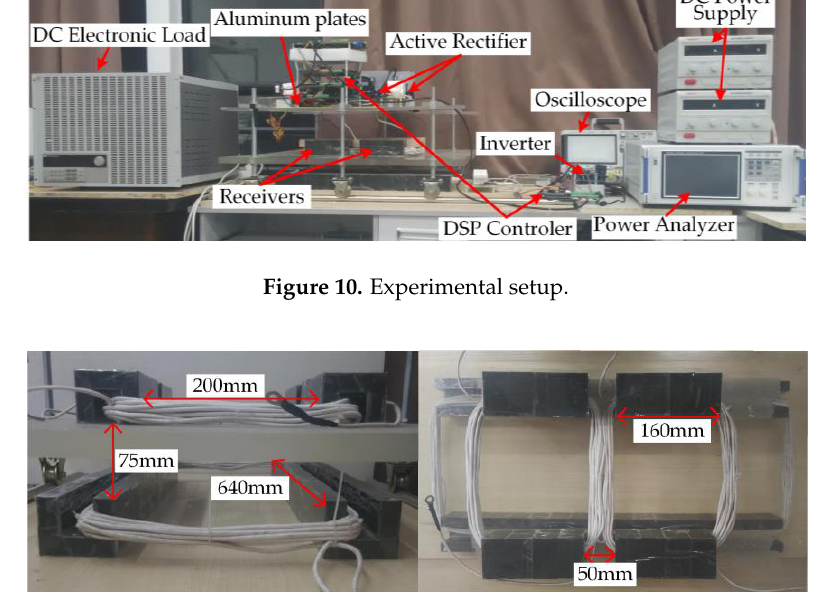
Figure 11. Setup of the transmitter coil and the receiver coils.